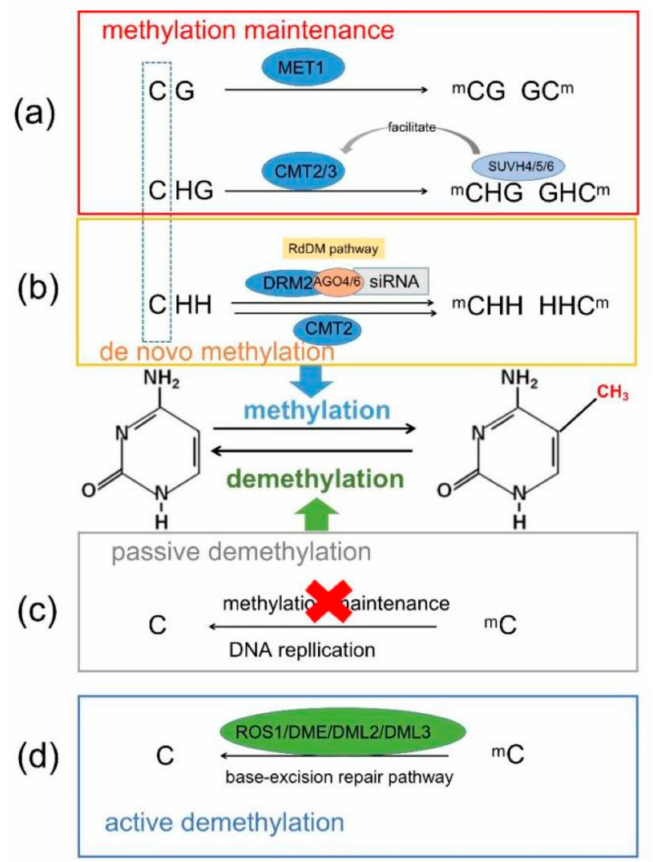
Figure 1. Dynamics of DNA methylation in plants. (H=A, T or C). Two DNA methylation processes in plants: ( a ) DNA methylation maintenance and ( b ) de novo DNA methylation. ( a ) Methyltransferase 1 (MET1) maintains symmetric CG site methylation. Chromosomal methylase (CMT2/3) maintains symmetrical CHG site methylation. The suppressor of the variegation homolog protein, SUVH4, SUVH5 and SUVH6 binds to the methylated CHG site and promotes the function of CMT3/CMT2. ( b ) Asymmetric de novo DNA methylation and CHH methylation performed by domain-rearranged methyltransferase 2 (DRM2) or CMT2, depending on the genomic region. DRM2 causes CHH methylation through the RNA-directed DNA methylation (RdDM) pathway, which depends on the 24 nt small interfering RNA (siRNA). siRNA is loaded onto the ARGONAUTE proteins (AGO), mainly AGO4 and AGO6, interacting with DRM2. DNA demethylation includes ( c ) passive demethylation and ( d ) active demethylation. ( c ) 5mC loses its methyl in passive demethylation during DNA replication. ( d ) 5mC losses are catalyzed by DNA glycosylases in active demethylation. DNA glycosylases including the repressor of silencing 1 (ROS1), Demeter (DME), Demeter-like 2 and 3